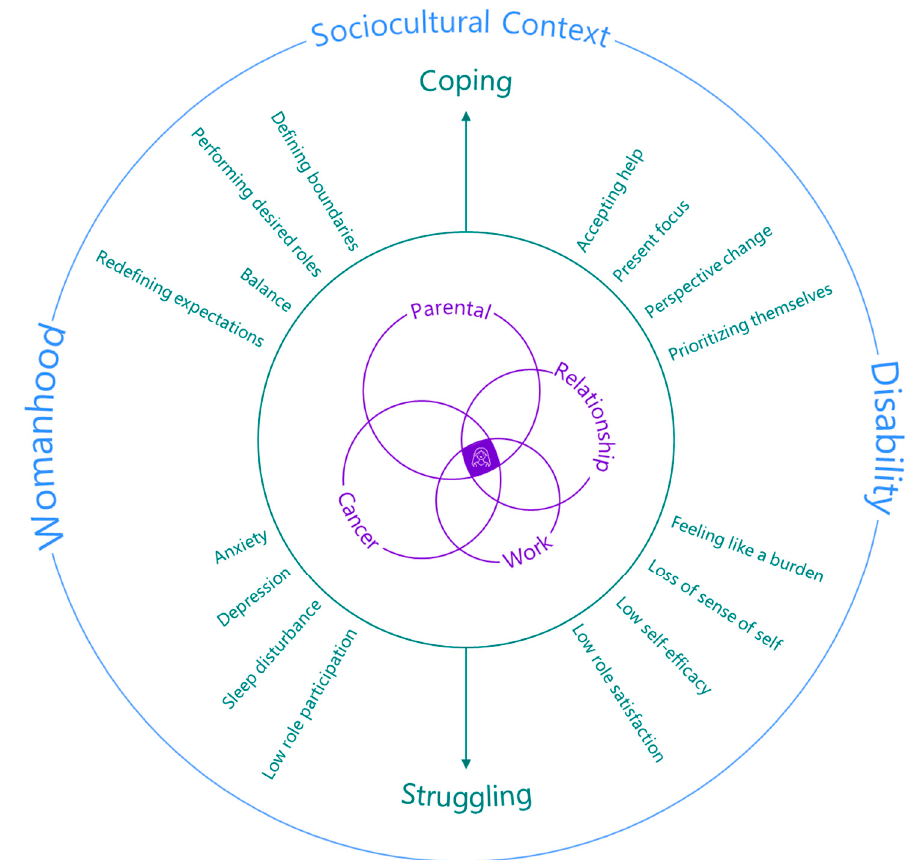
Figure 6. Role Coping as a Mother with Cancer (RCMC) model. Note. The RCMC model comprises three components: (1) the interacting roles that mothers with cancer occupy (the relative size of each circle signi fi es the priority that the mothers gave to the role) (purple); (2) the consequences of struggling to cope with role con fl ict caused by their multiple role demands and the strategies used to help them cope (green); (3) the sociocultural understanding of womanhood and disability that impacts how mothers cope with their roles and the expected demands within speci fi c roles (blue). All the dimensions of the RCMC model are in a continual and multidirectional state of in fl uence.